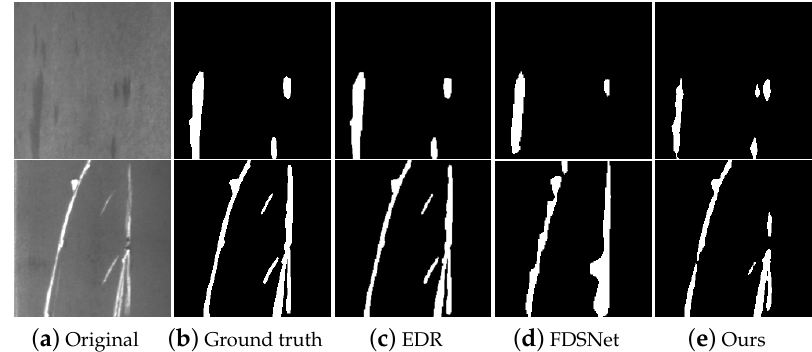
Figure 6. The outputs of EDR method and ours on SD-Saliency-900 dataset.